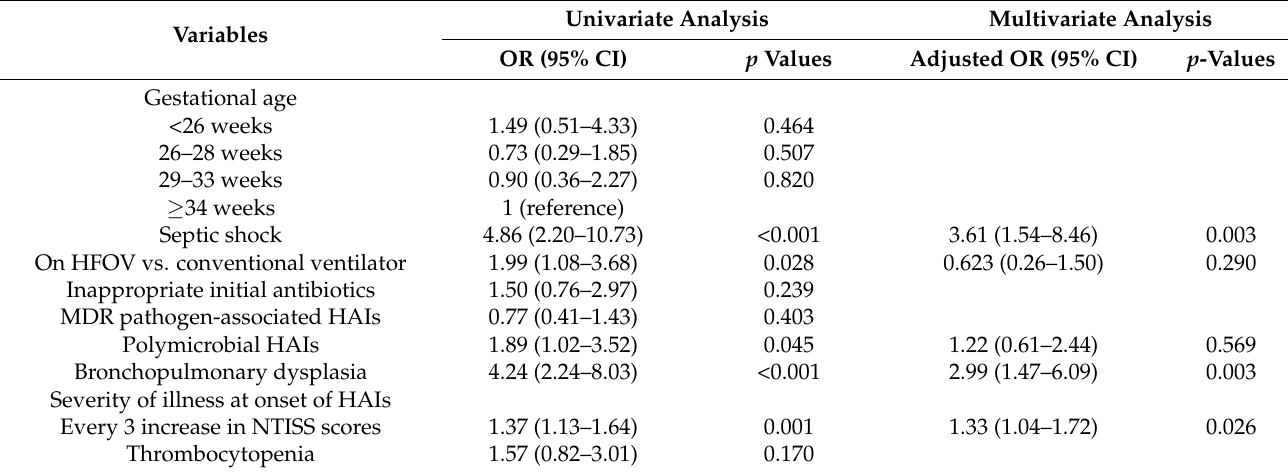
Table 4. Multivariate logistic regression analysis for independent risk factors of sepsis-attributable mortality in neonates with healthcare-associated